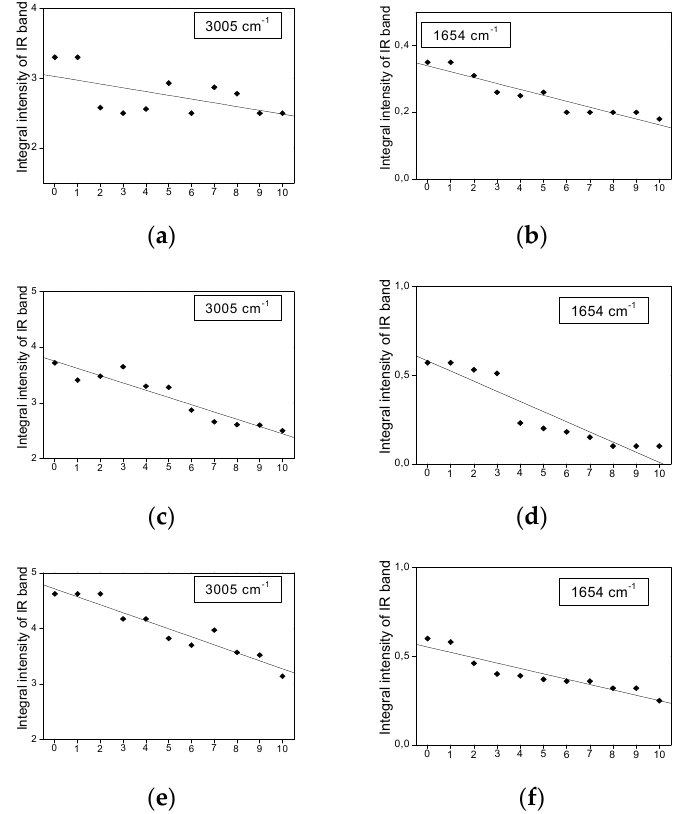
Figure 7. The dependence of the band intensity at 3005 and 1654 cm − 1 vs. heating time, observed in the IR spectra of palm ( a , b ), rice bran ( c , d ), and rapeseed ( e , f ) oils. The bands at 3005 cm − 1 show a small decrease in their intensity with the increasing heating time. The bands at 1654 cm − 1 show a significant decrease in their intensity with the increasing heating time.